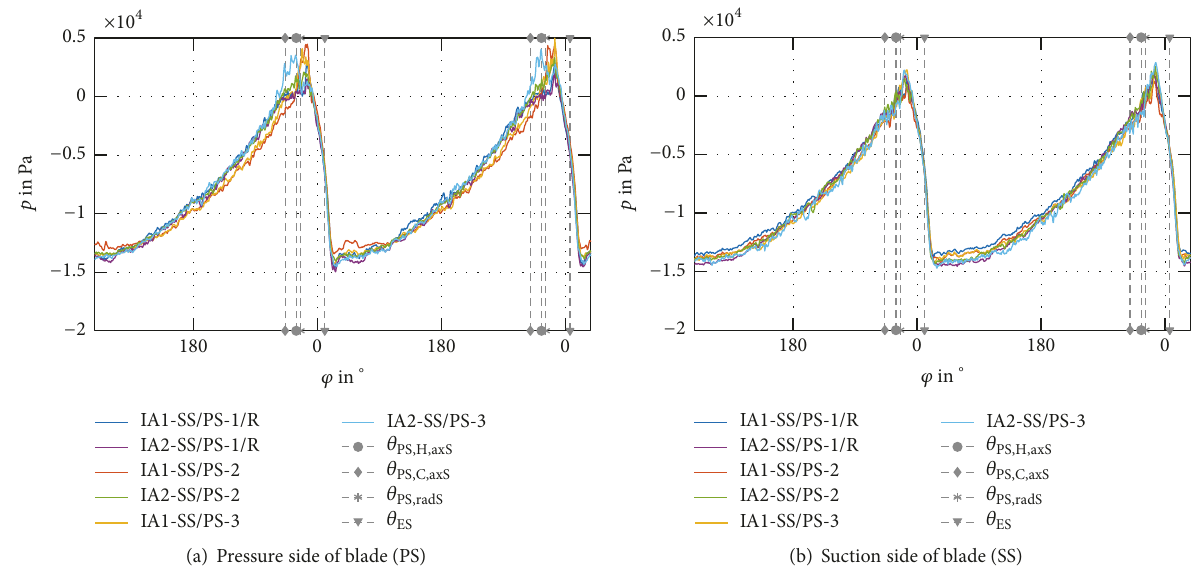
Figure 11: Time trend of pressure signal on the blade surface at a rotational speed of 𝑓 = 50 Hz and a pressure difference Δ𝑝 12, red = 14,000Pa. Note . Configuration IAx-PS-1 is not shown.